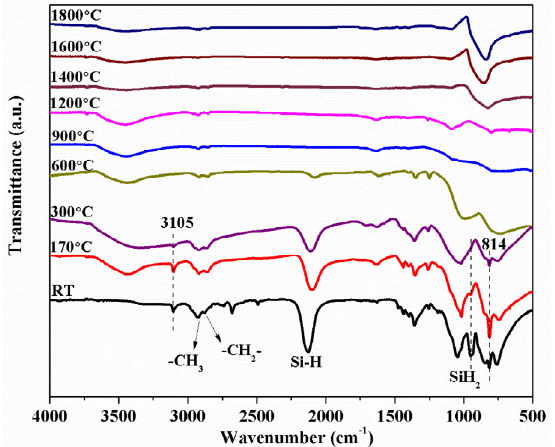
Fig. 2 FT-IR spectra of cross-linked (a) AHPCS, (b) ABZ-1, (c) ABZ-2, and (d) ABZ-3 at 170 ℃ .